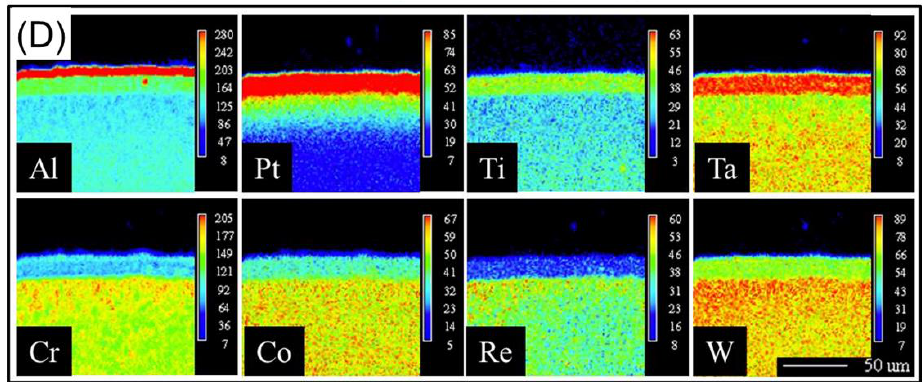
Figure 8. Cross-sectional BSE images and EPMA mappings of the ( A ) + ( C ) standard Pt-diffused γ/γ’ bond coat; and ( B ) + ( D ) Pt-diffused γ’-phase bond coat after oxidation at 1150 °C for 50 h.